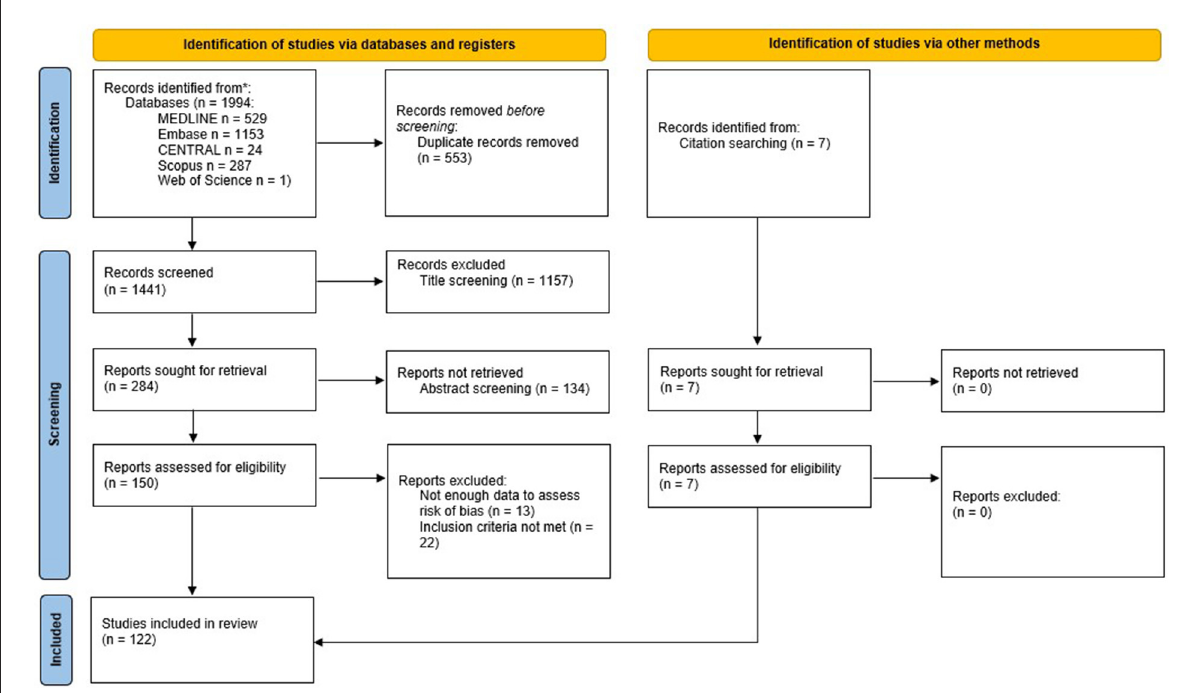
FIGURE4 PRISMA flowchart for the systematic review. From Page et al. (2021). For more information, visit: